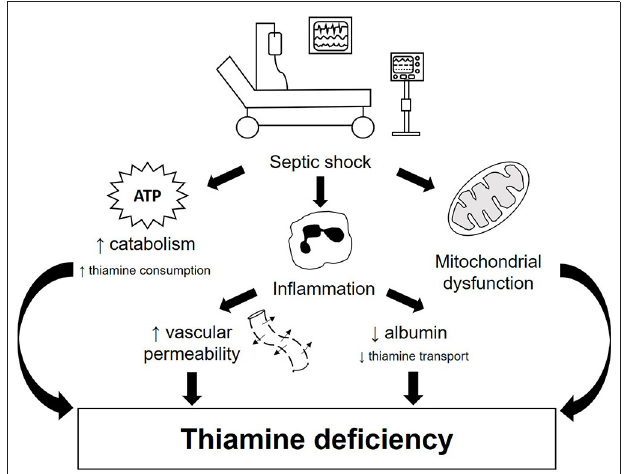
FIGURE 1 | Pathophysiology of thiamine deficiency in septic shock patients. Thiamine deficiency in septic shock occurs both due to increased need